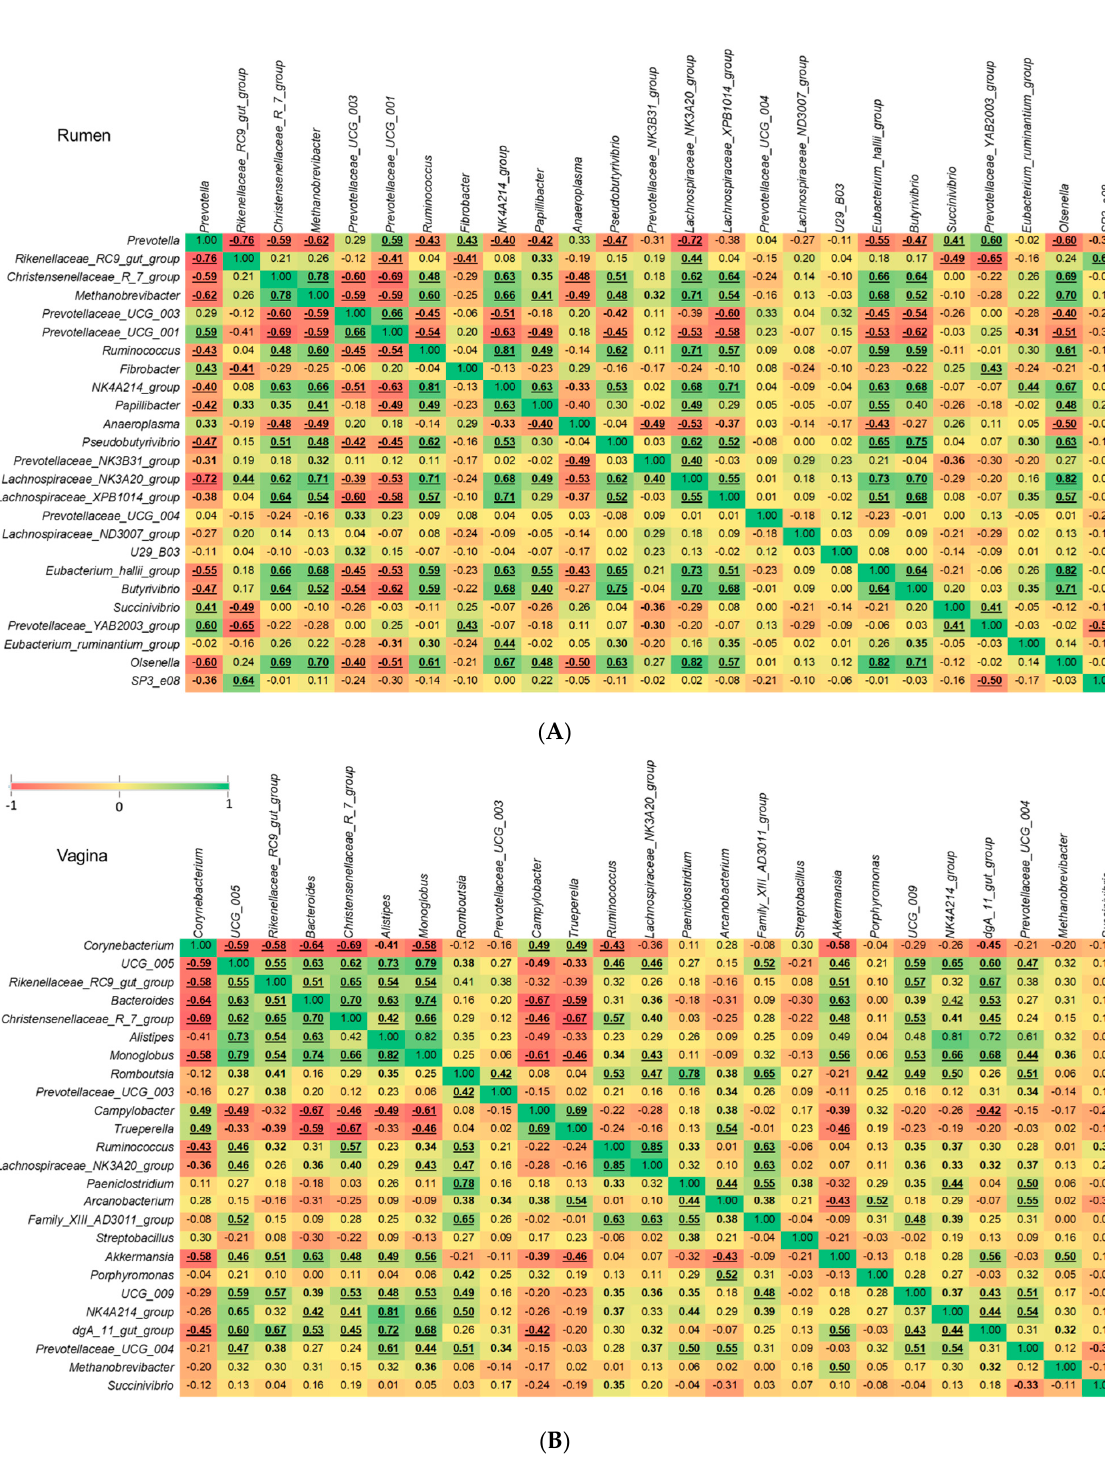
Figure 7. Correlations between the 25 most relatively abundant genera in the ruminal ( A ) and vaginal ( B ) microbiota of virgin yearling heifers. Spearman’s rank correlation coefficients ( r ). Bold correlation coefficients with 0.01 ≤ p < 0.05, and underlined bold correlation coefficients with p < 0.01.